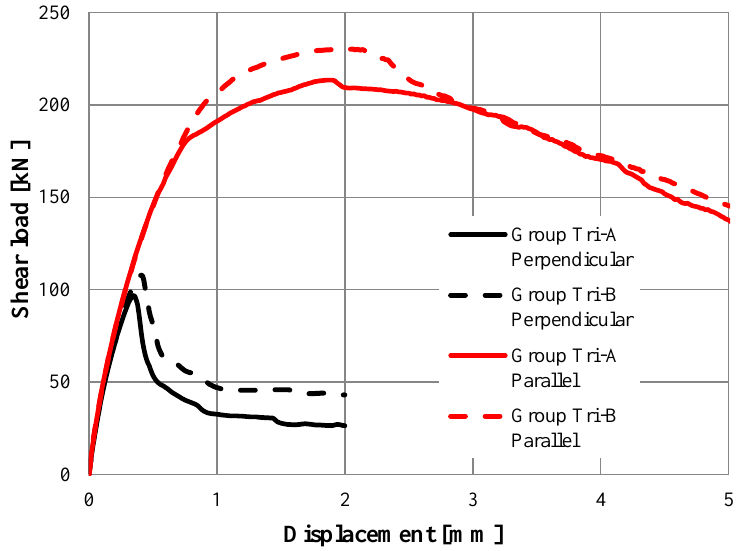
Figure 6. Load-displacement curves obtained for triangular groups from numerical analysis.